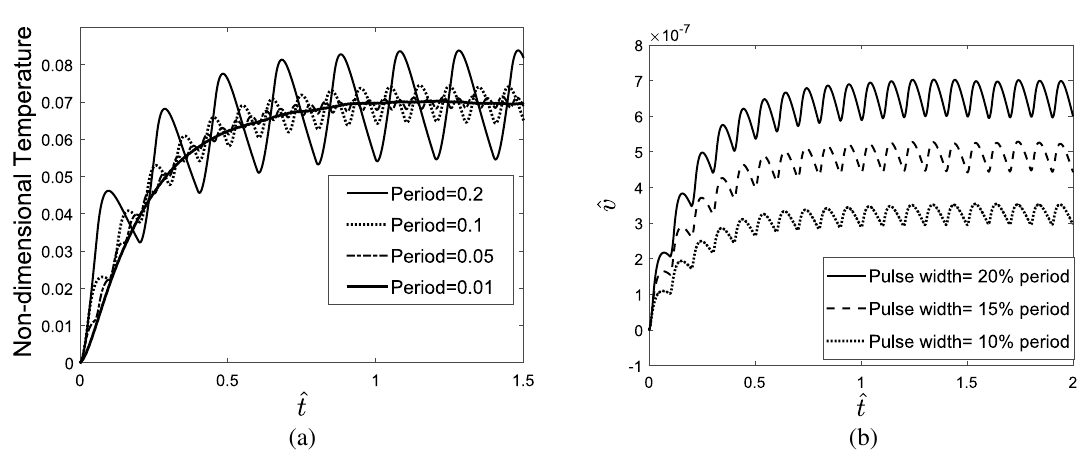
Figure 7. ( a ) The effect of the period, ( b ) the effect of the width of the repetitive pulses on the thermomechanical response of the